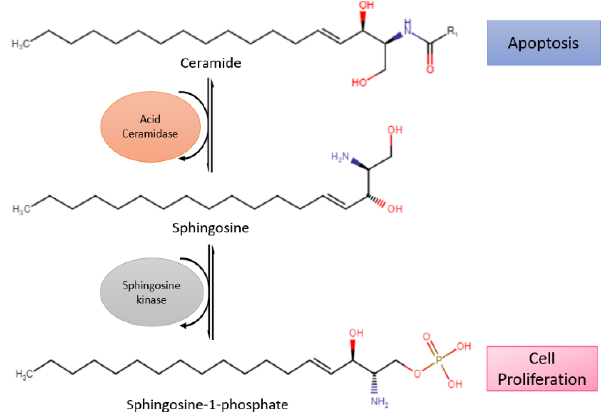
Figure 2. Reaction of acid ceramidase (ASAH1), a lysosomal enzyme that converts ceramides into sphingosine, which is further converted to sphingosine-1-phosphate (S1P) by sphingosine kinase. Ceramide promotes apoptosis while S1P stimulates cell survival and proliferation.